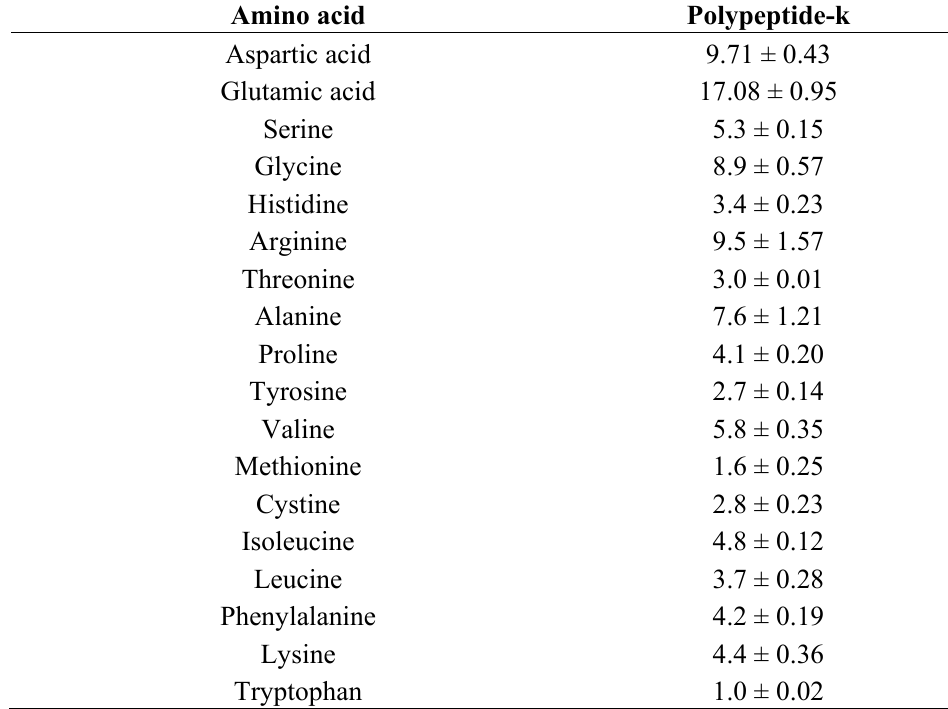
Table 2. Amino acid composition of polypeptide-k isolated from Momordica charantia .